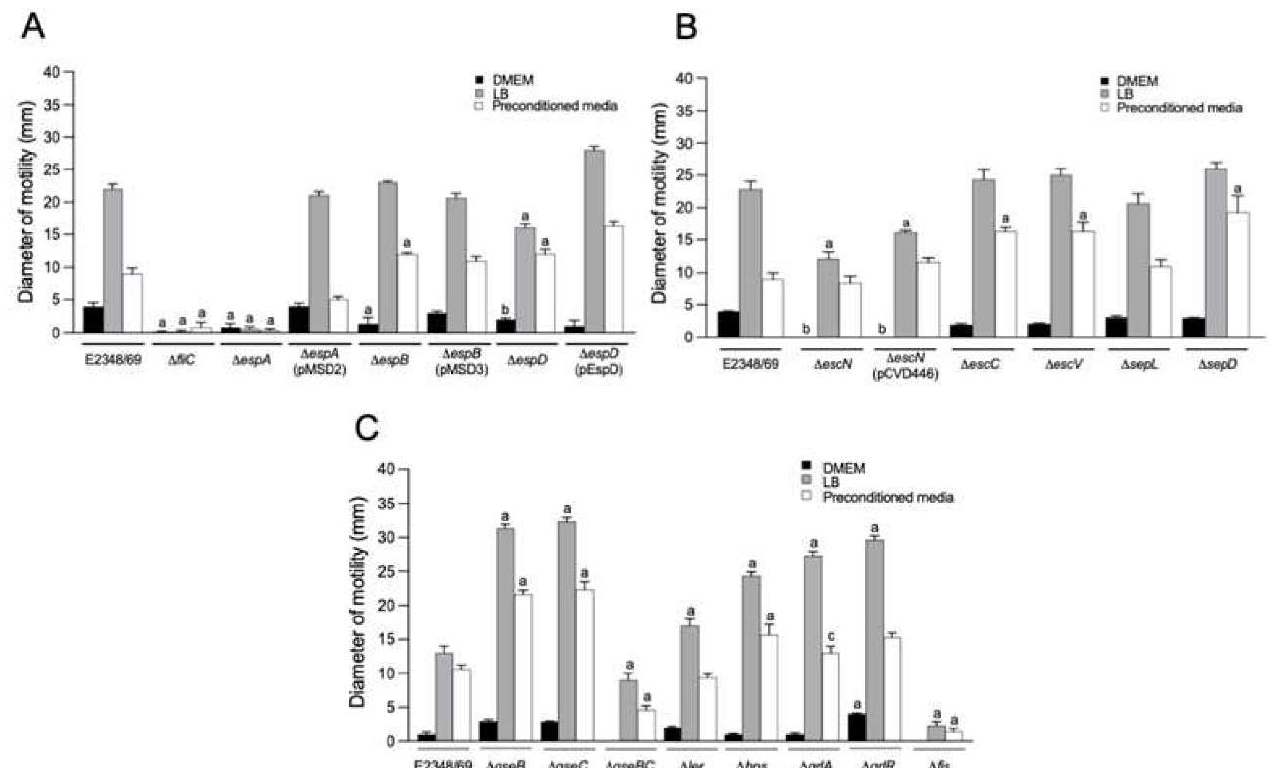
Figure 6. Motility of strains mutated in virulence and global regulators. ( A – C ) Motility of the indicated strains grown in LB, DMEM and preconditioned DMEM containing 0.3% agar. The data shown are the mean of three experiments performed in triplicate on different days. Letters a, b, or c show the statistical significance of the mutants tested with respect to E2348/69 grown in each condition (one-way ANOVA test, followed by Tukey’s multiple comparison), a = p < 0.001; b = p < 0.01; c = p < 0.05.